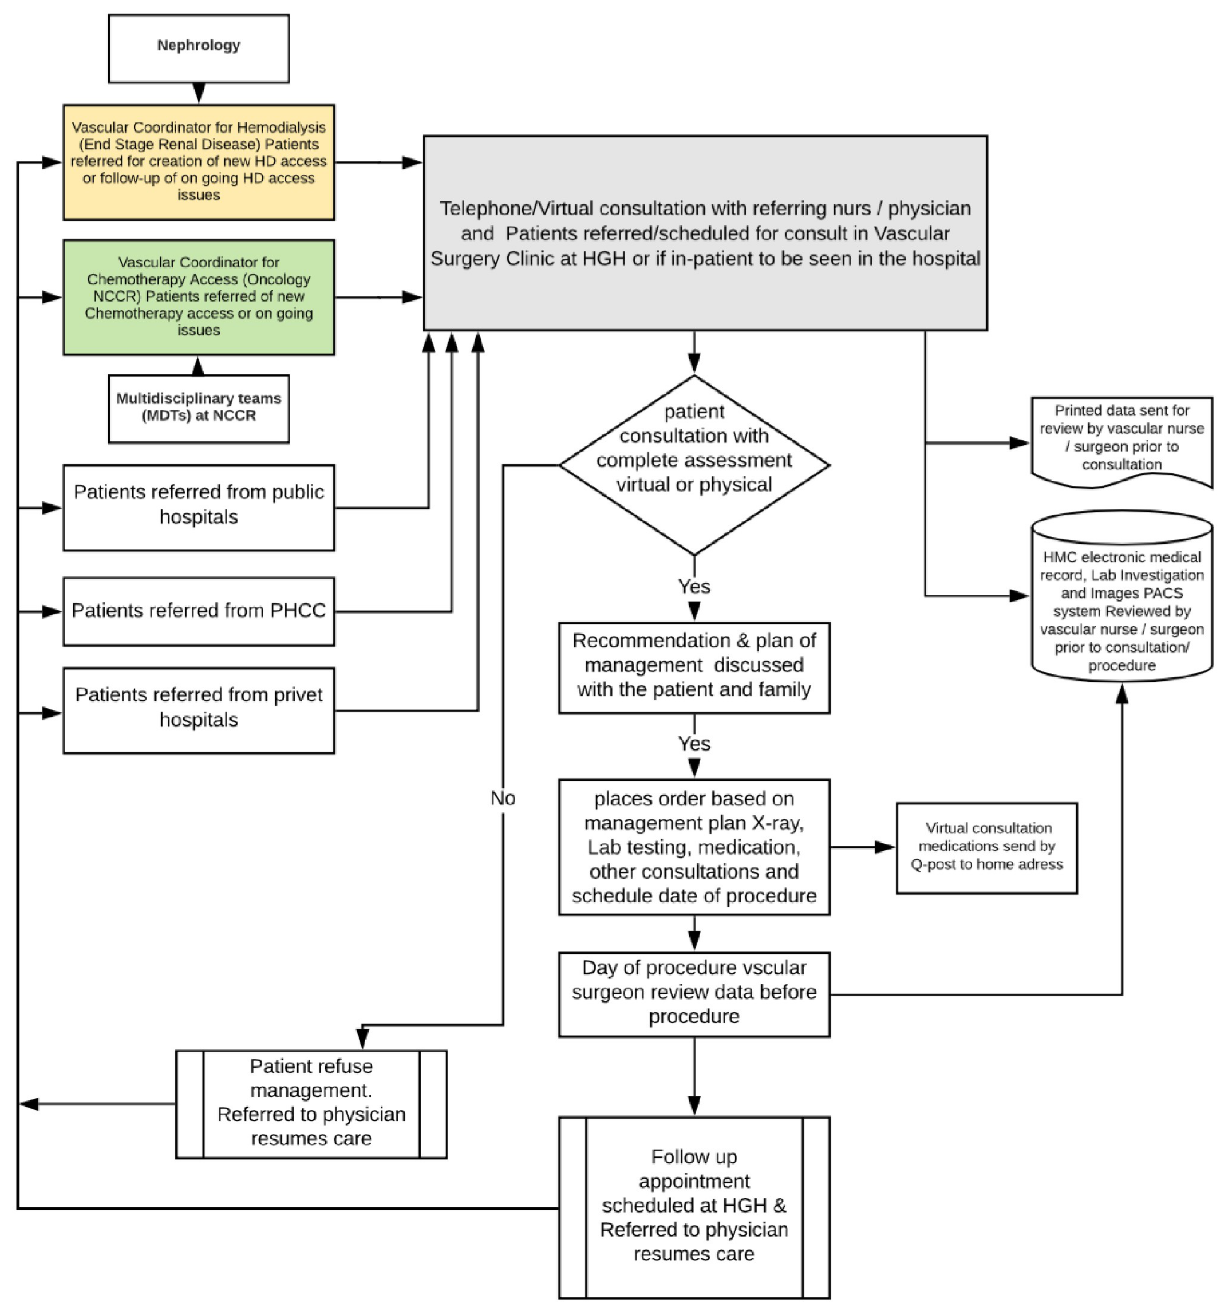
Fig 1. Telephone/Virtual consultation in vascular surgery clinic at Hamad General